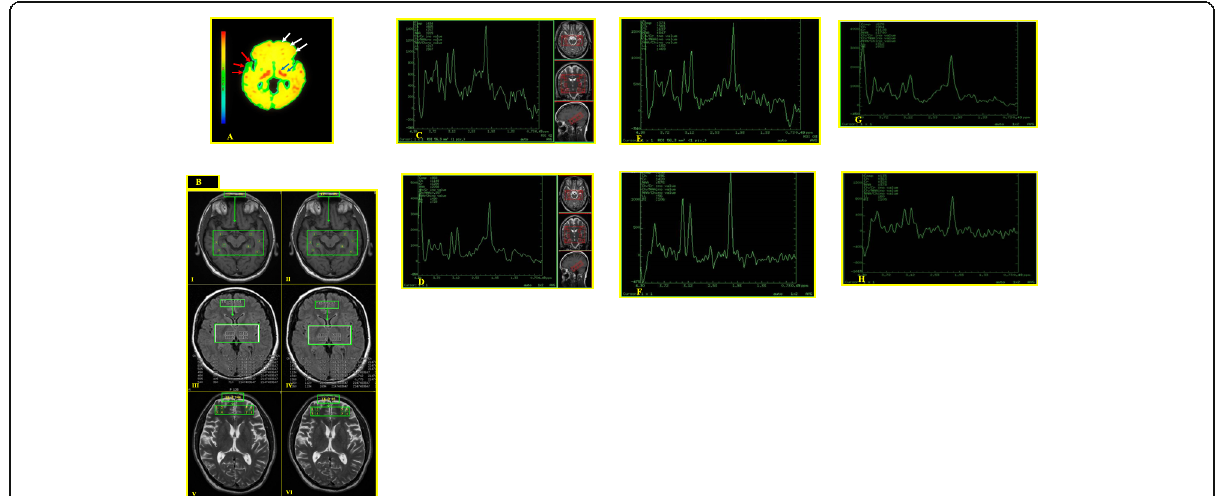
Fig. 5 a – h A 27-year-old male patient with non-lesional right temporal lobe FIAE. The visual-based analysis of the axial PASL-MRI colour-coded cerebral perfusion map ( a ) reflects the hypoperfusion of the epileptogenic right temporal lobe (red arrows) and the contra-lateral right frontal lobe, which represented the cerebral area of seizure spread (white arrows) and the contra-lateral left thalamus (blue arrows ) . The estimated rCBF for the right and left temporal lobes was 49.76 and 67.98 ml/100 g/min, respectively, with ASLAI% of 30.95%. The estimated rCBF of the right and left frontal lobes was 73.56 and 59.78 ml/100 g/min, respectively, with ASLAI% of 20.67%, while the estimated rCBF of the right and left thalami was 70.04 and 65.69 ml/100 g/min, respectively, with ASLAI% of 6.41%. The MV 1H-MRS picture maps illustrating the studied ROIs in ( b ) (I – VI). The MRS spectra of the right and left temporal lobes ( c and d , respectively), demonstrated increased MI/NAA, Glx/NAA and Glx/Cr, as well as decreased NAA/(Cho + Cr) ratios in the zone of epileptogenic activity in the right temporal lobe ( c ) in comparison to the contra-lateral left temporal lobe ( d ) with these ratios were: [NAA/(Cho + Cr) = 0.59 and 0.85 with %AF of 36.11%, MI/NAA = 0.72 and 0.35 with %AF of 34.58%, Glx/ NAA = 1.66 and1.34 with %AF of 21.33% and Glx/Cr = 1.62 and 1.30 with %AF of 21.92%] for the right ( c ) and left ( d ) temporal lobes, respectively. On the other hand, the MRS spectra of the contra-lateral left frontal lobe ( f ) and the contra-lateral left thalamus ( h ) showed decreased MI/NAA and NAA/(Cho + Cr), as well as increased Glx/NAA and Glx/Cr ratios when compared to the ipsilateral frontal lobe ( e ) and thalamus ( g ). These ratios were [NAA/(Cho + Cr) = 0.72 and 0.67 with %AF of 7.19%, MI/NAA = 0.38 and 0.27 with %AF of 33.85%, Glx/NAA = 1.33 and 1.65 with %AF of 21.47% and Glx/Cr = 1.28 and 1.59, with %AF of 21.60%] for the right and left frontal lobes, respectively, while these ratios were [NAA/(Cho + Cr) = 0.71 and 0.58 with %AF of 20.16%, MI/NAA = 0.42 and 0.20 with %AF of 70.97%, Glx/ NAA = 1.30 and 1.55 with %AF of 8.77% and Glx/Cr = 1.27 and 1.52, with %AF of 8.96%] for the right and left thalami,